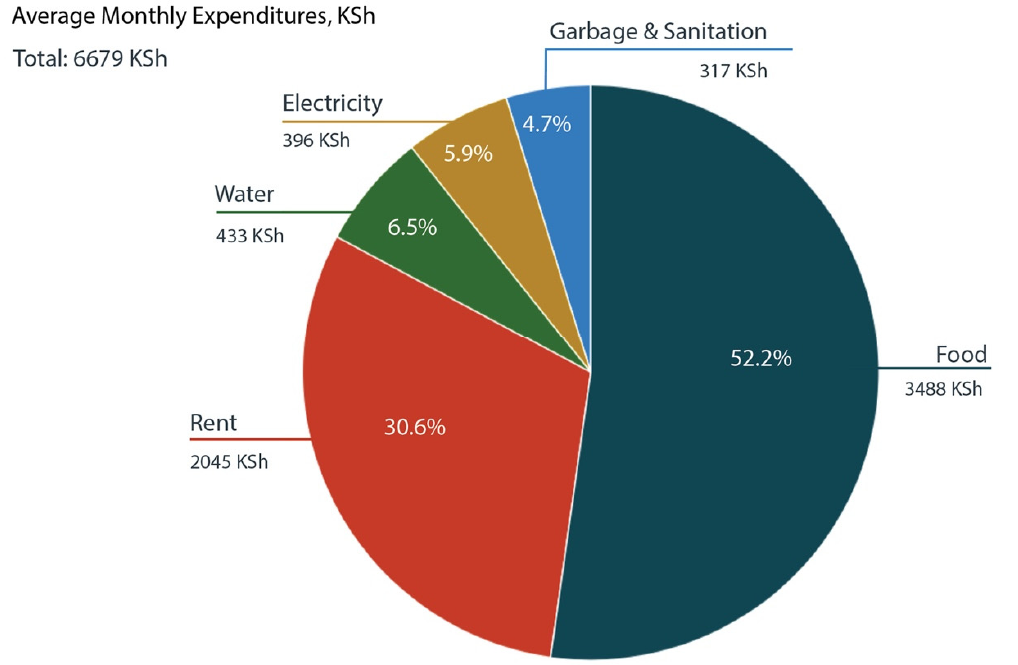
Figure 2. Average Monthly Expenditures for Household in Mukuru, Nairobi (Kenyan Shillings— KSh).